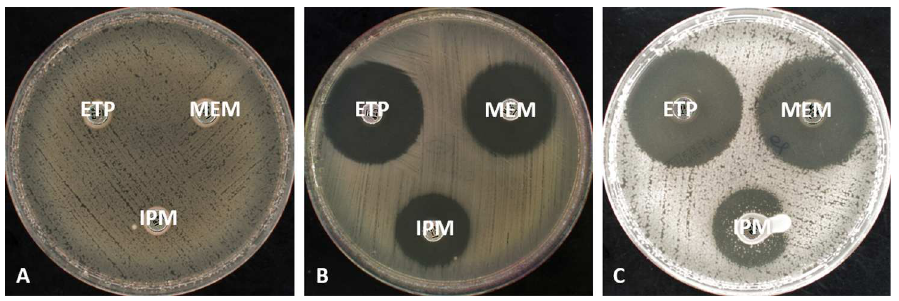
Fig 1. A: OXA-48 producing E . coli , CIM positive; B: CTX-M15 producing K . pneumoniae , CIM negative;C: Overexpressed cephalosporinase+ CTX-M-15 producing E . cloacae , CIM negative, presenceof microcolonies in the inhibitorydiameterof imipenemdisk. ETP : Ertapenem; IPM : Imipenem; MEM :